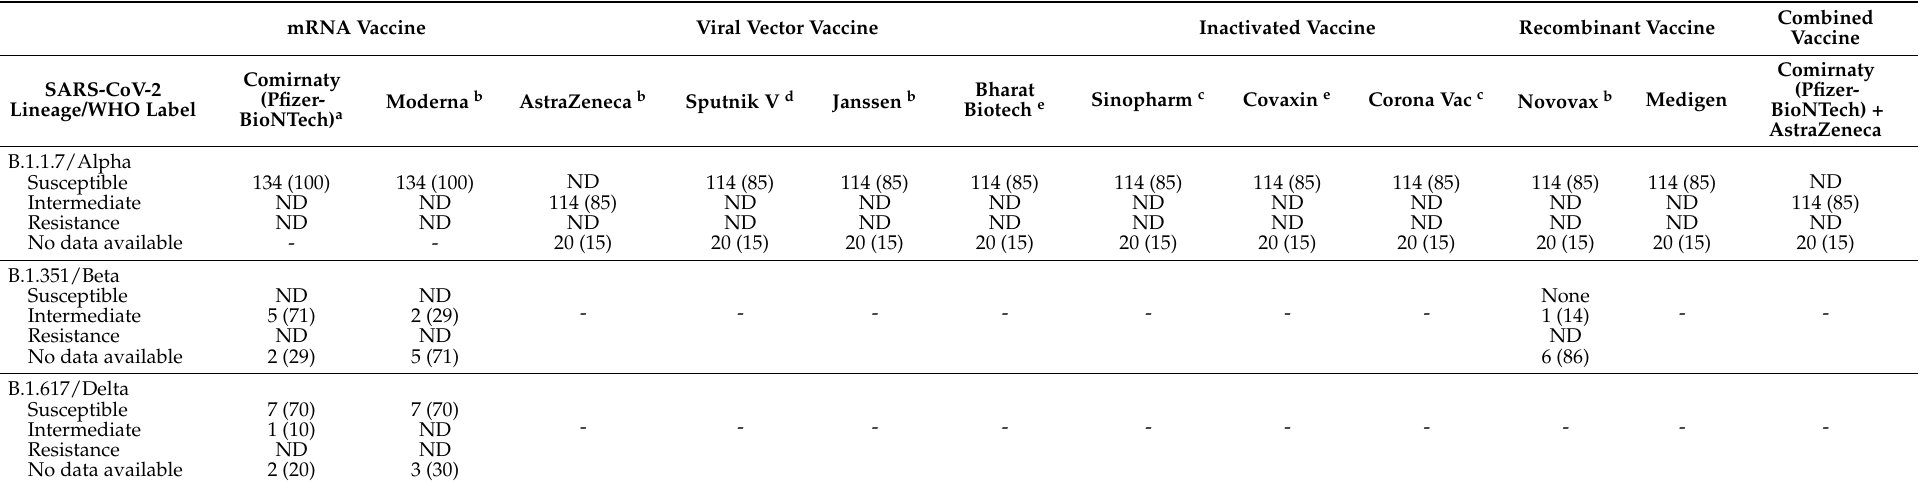
Table 4. Susceptibility rate of SARS-CoV-2 lineages to all approved COVID-19